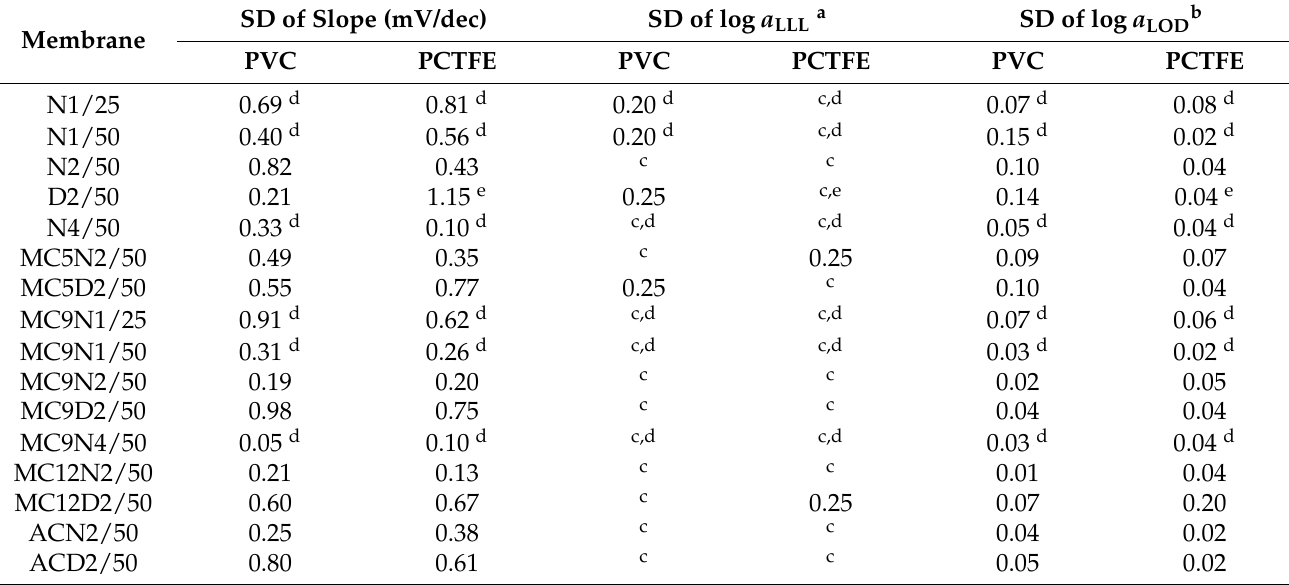
Table A6. Pooled standard deviations or standard deviations for the average response characteristics in Table A5. All linear regressions had an R 2 0.999. The number of measurements and the number of sensors were n = 2 and k = 2, respectively, ≥ unless noted otherwise. See Table 1 for membrane